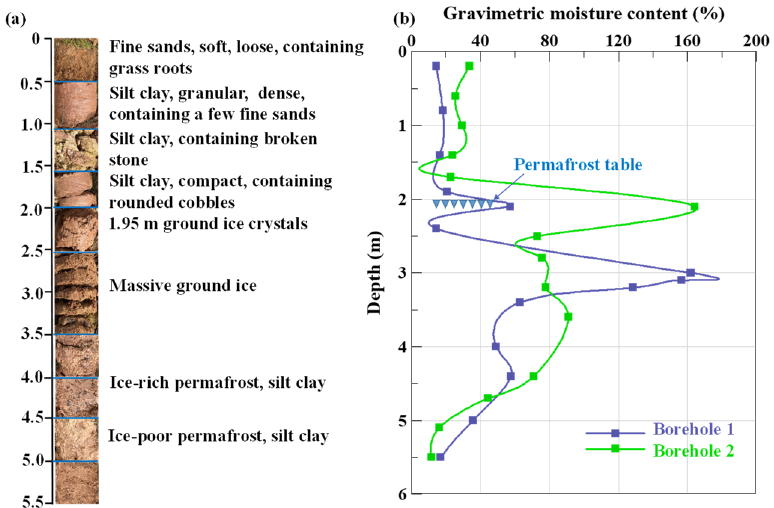
Figure 3. Drilling borehole information of the K1129W thaw slump. ( a ) Borehole logging and ( b ) gravimetric moisture content.